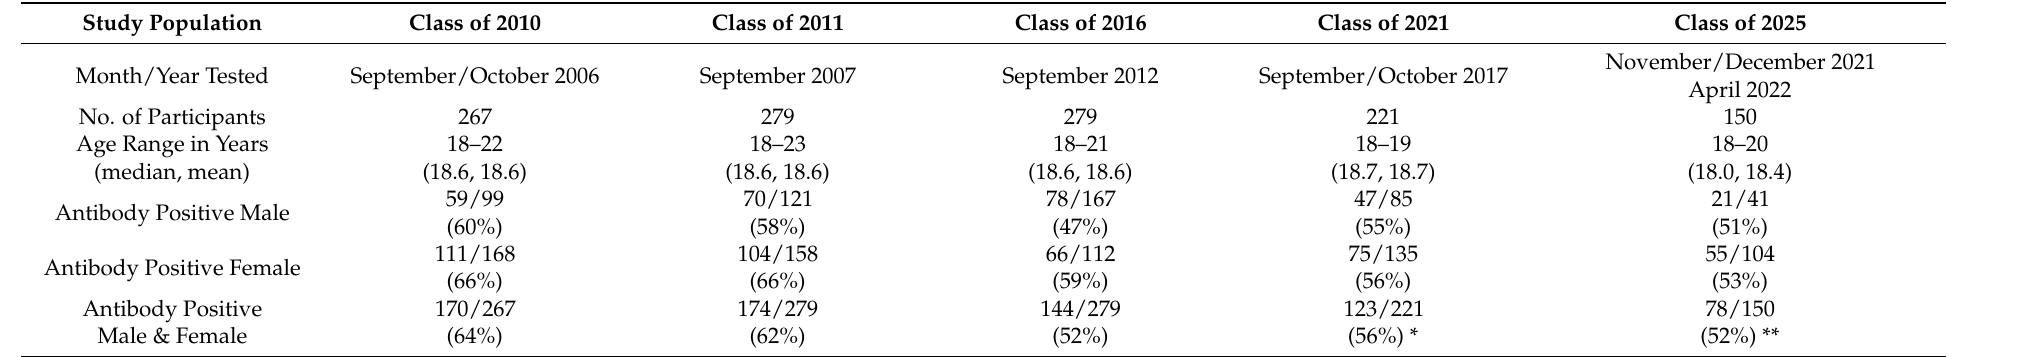
Table 1. Epstein-Barr Virus Antibody Prevalence in University of Minnesota